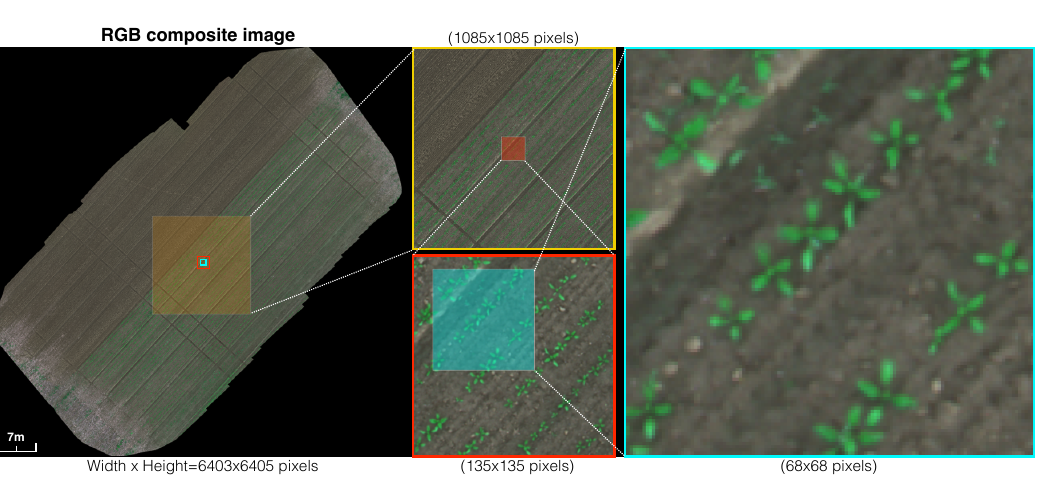
Figure 4. Multispectral cameras and irradiance (Sunshine) sensors’ configuration. Both cameras are facing-down with respect to the drone body and irradiance sensors are facing-up. Figure 5 exemplifies the RGB channel of an orthomosaic map generated from data collected with a RedEdge-M camera. The colored boxes in the orthomosaic map indicate areas of different scales on the field, which correspond to varying zoom levels. For example, the cyan box on the far right (68 × 68 pixels) shows a zoomed view of the area within the small cyan box in the orthomosaic map. This figure provides qualitative insight into the high resolution of our map. At the highest zoom level, crop plants are around 15–20 pixels in size and single weeds occupy 5–10 pixels. These clearly demonstrate challenges in crop/weed semantic segmentation due to their small sizes (e.g., 0.05 m weeds and 0.15 m crops) and the visual similarities among vegetation.